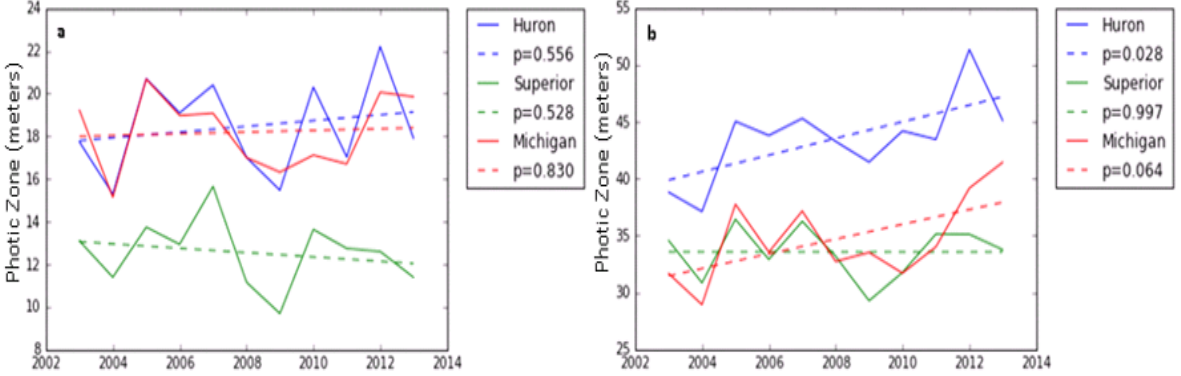
Figure 5: Annual photic zone depth from 2003-2013 for the Upper 3 Great Lakes. Figure 5a shows results for nearshore areas where the depth is 30 meters or less. Figure 5b shows results for offshore areas where the depth is greater than 30